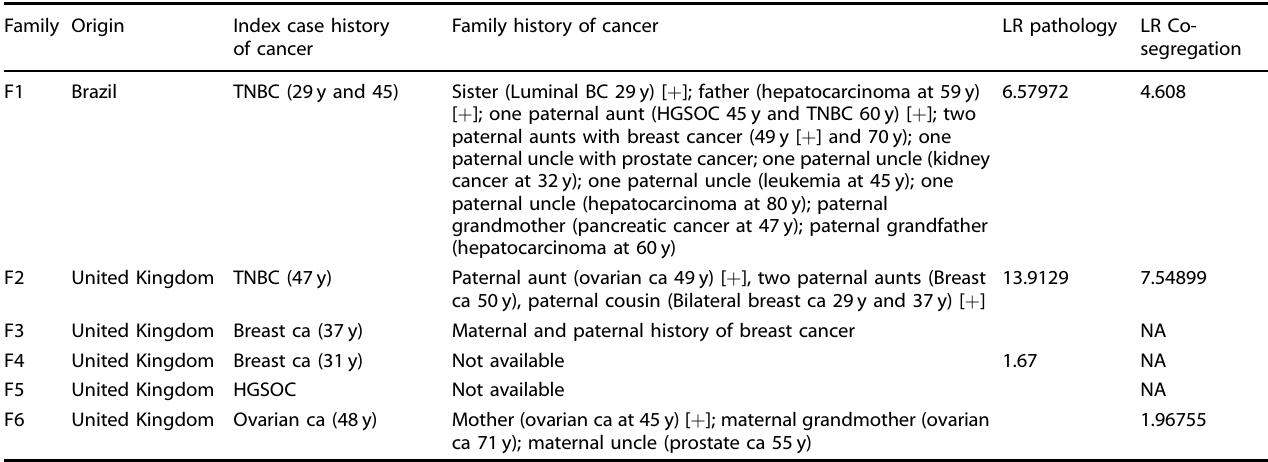
Table 6. Clinical, pathological and co-segregation data available for the variant BRCA1 c.4963T>C (Suppl. Fig. 4 presents the pedigree of F1 family). Family